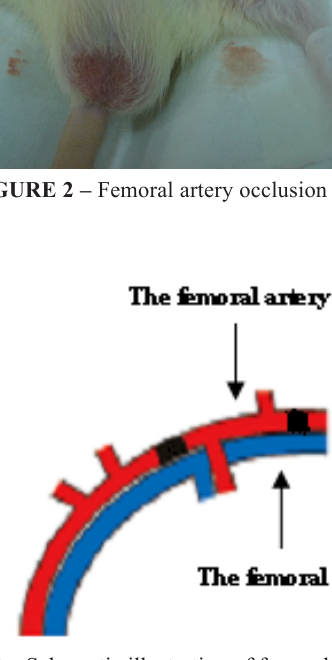
FIGURE 3 – Schematic illustration of femoral artery occlusion 10